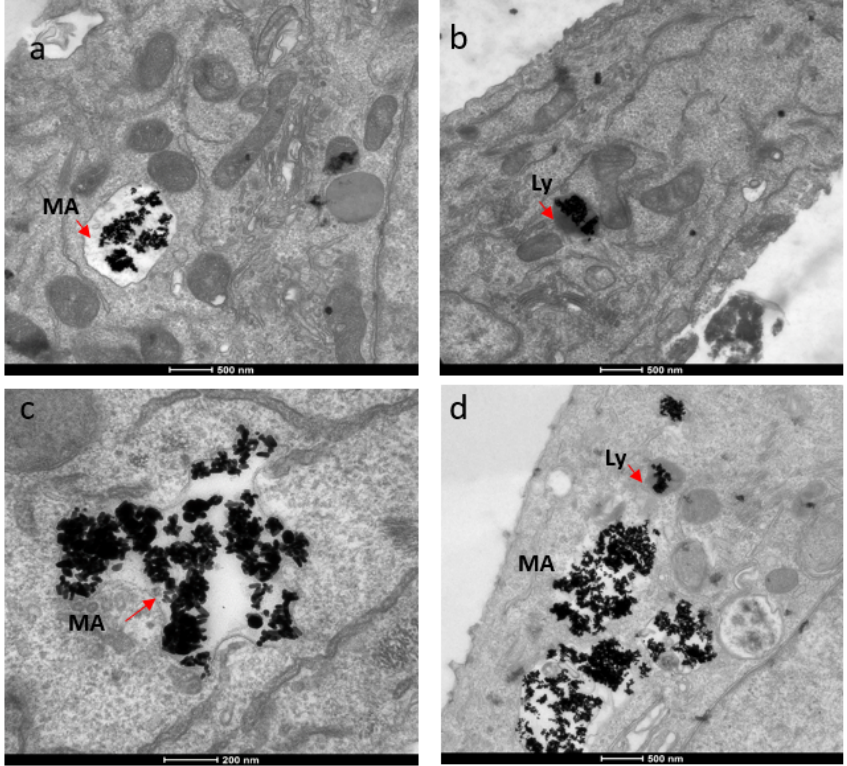
Figure 8. TEM images showing localization of gold nanorods in macropinosomes and lysosomes in both SKBR-3 and MCF-7 cell lines. AuNR localization in ( a ) macropinosomes (MA) and ( b ) lysosomes (Ly) of SKBR-3 cells. ( c ) Macropinosomes (MA) containing gold nanorods in MCF-7 and ( d ) lysosomes (Ly) containing gold nanorods in MCF-7. Red arrows point out macropinosomes and lysosomes containing gold nanorods in each image. Electron photomicrographs shown are representative of at least three independent experiments with similar conditions.